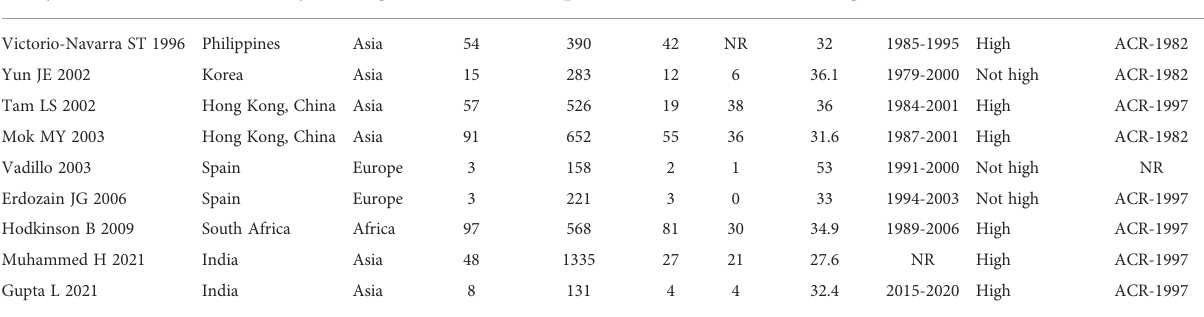
TABLE 1 Summary of the studies that reported the TB incidence among SLE patients.